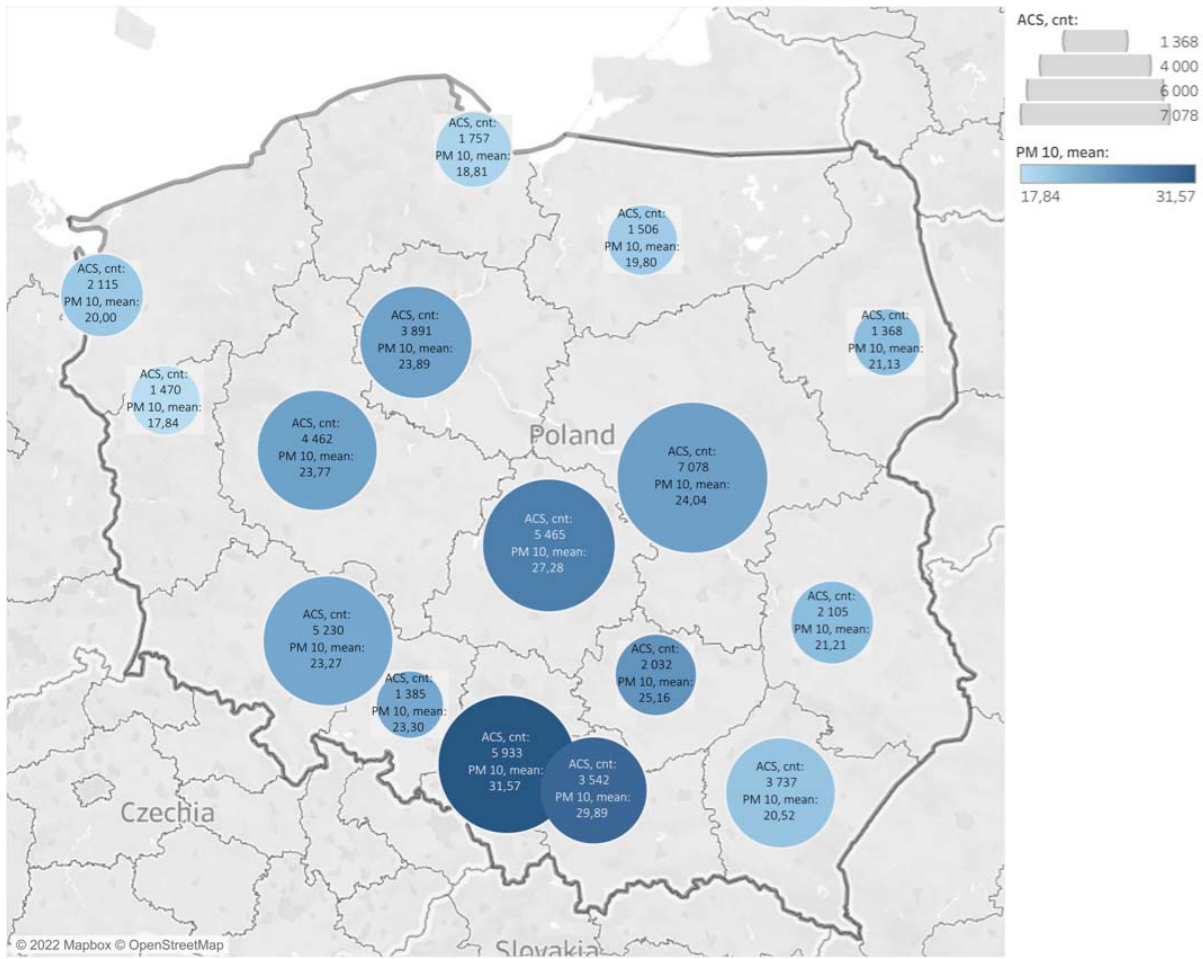
Figure 3. Distribution of acute coronary syndromes and mean PM10 levels in 2020. The circles indicate the accumulation of air pollution in a region. ACS—acute coronary syndrome.